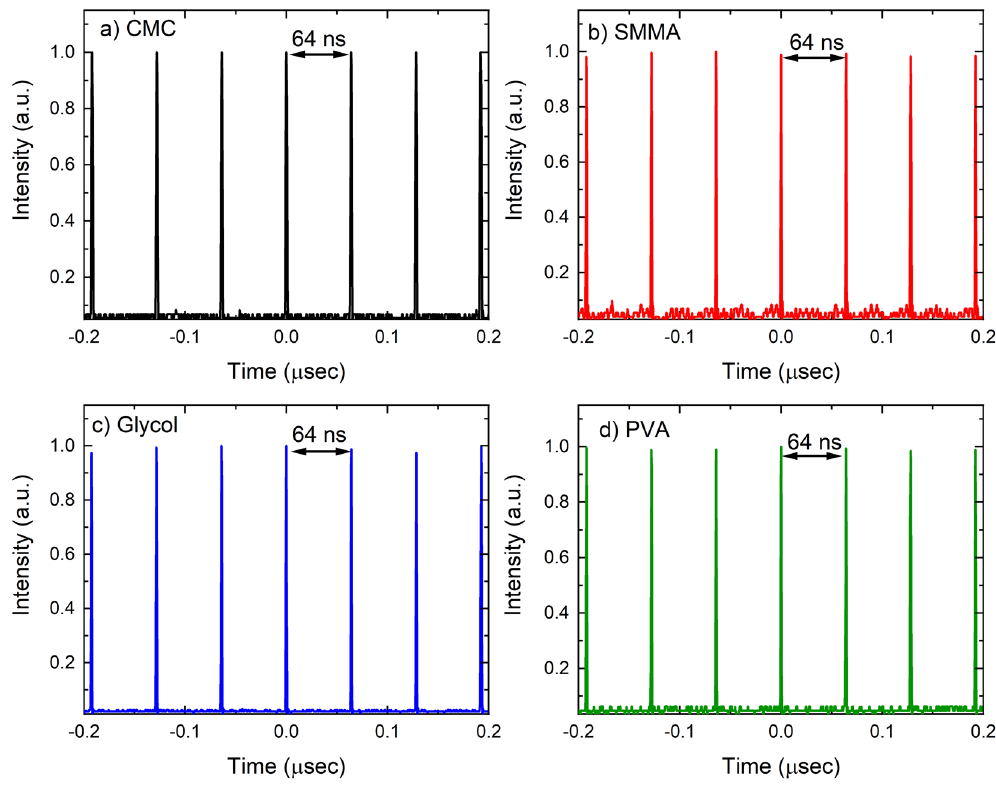
Figure 3. Pulse train obtained in various cases ( a ) CMC, ( b ) SMMA, ( c ) Glycol and ( d ) PVA. In all situations we have obtained a pulse separation of approximately 64